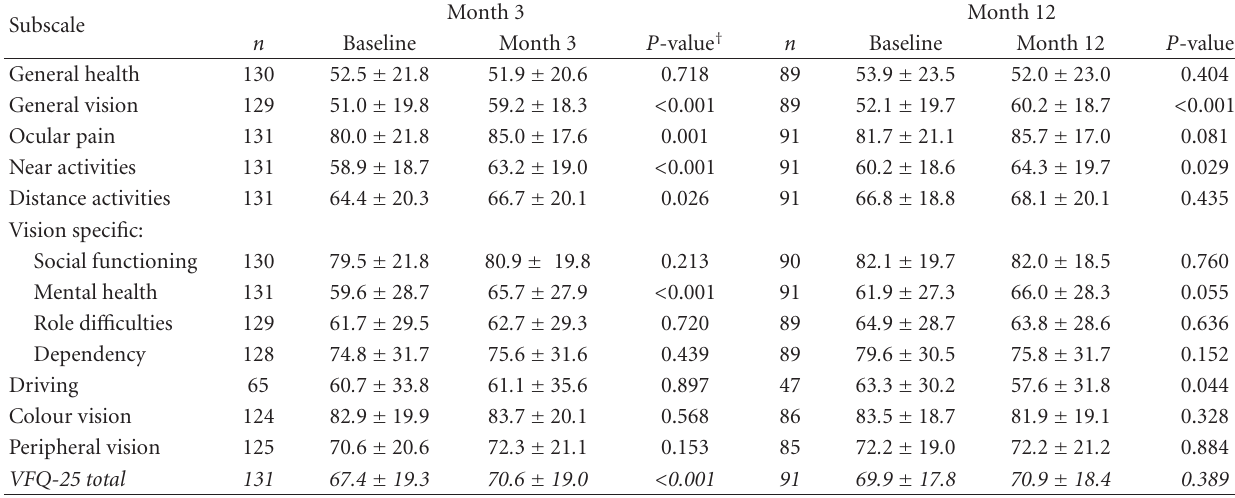
Table 3: VFQ-25 subscale and total scores at 3 and 12 months. Values are shown as mean ± SD.